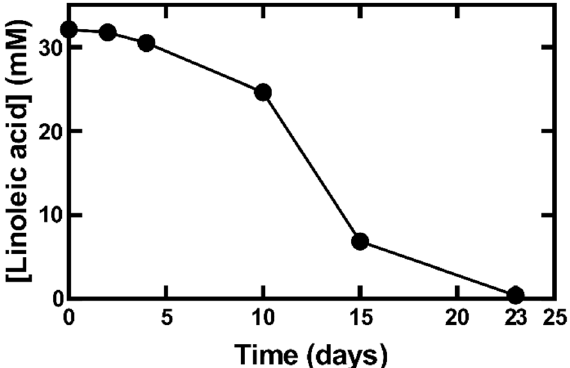
Figure 3. Autoxidation of linoleic acid. Linoleic acid was incubated at room temperature, and on different days an aliquot was taken for quantification via HPLC. Linoleic acid on days 2, 4, 10, 15, and 23 was quantified by comparing the peak area of products relative to day 0 (32 mM). The results shown (mean ± S.D.) were averaged from three replicates ( n = 3).